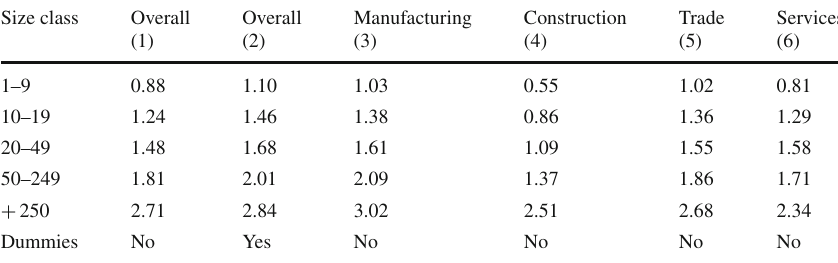
Table 2 Average productivity by size